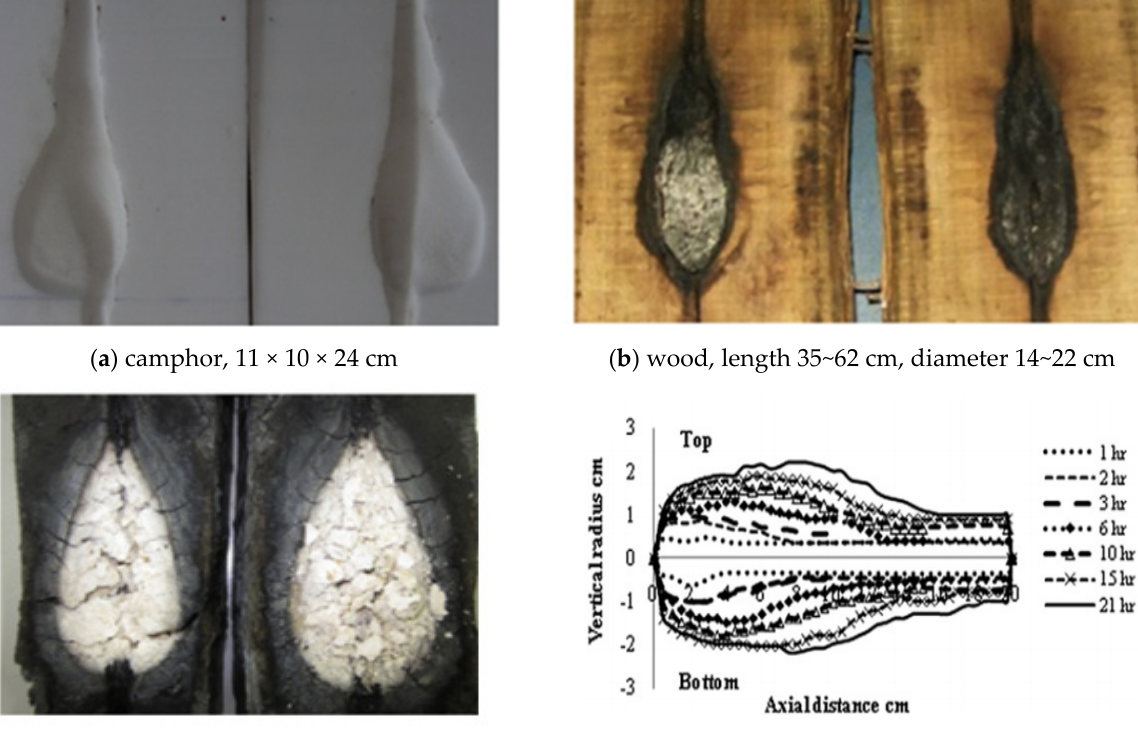
Figure 10. Cavity growth behavior of CRIP technology (from [32]).